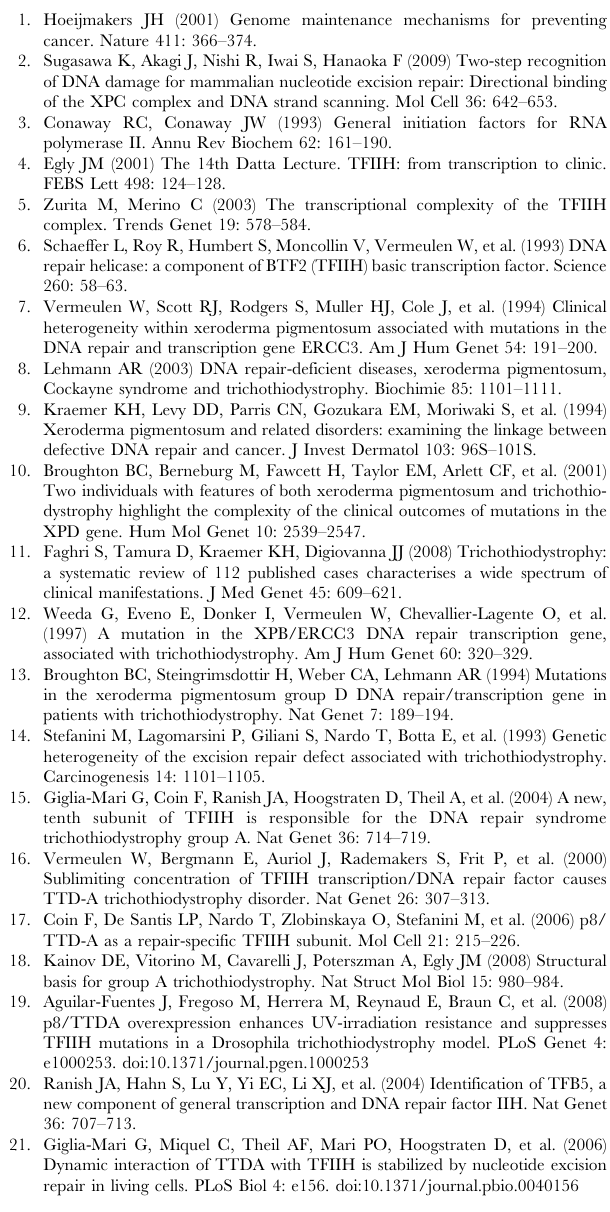
Ttda + / 2 LNL mice, distributed over male and females, obtained